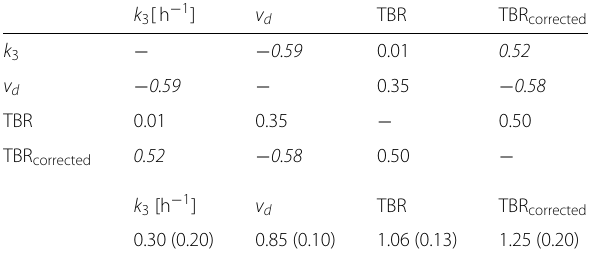
Table 1 Top: Correlation matrix of Pearson correlation coefficients between the mean voxel-scale parameters across the twenty tumours studied using the 2-h data sets. Bottom: Population average values of the corresponding voxel-scale coefficients. Standard deviations of mean values across patients are indicated in parentheses